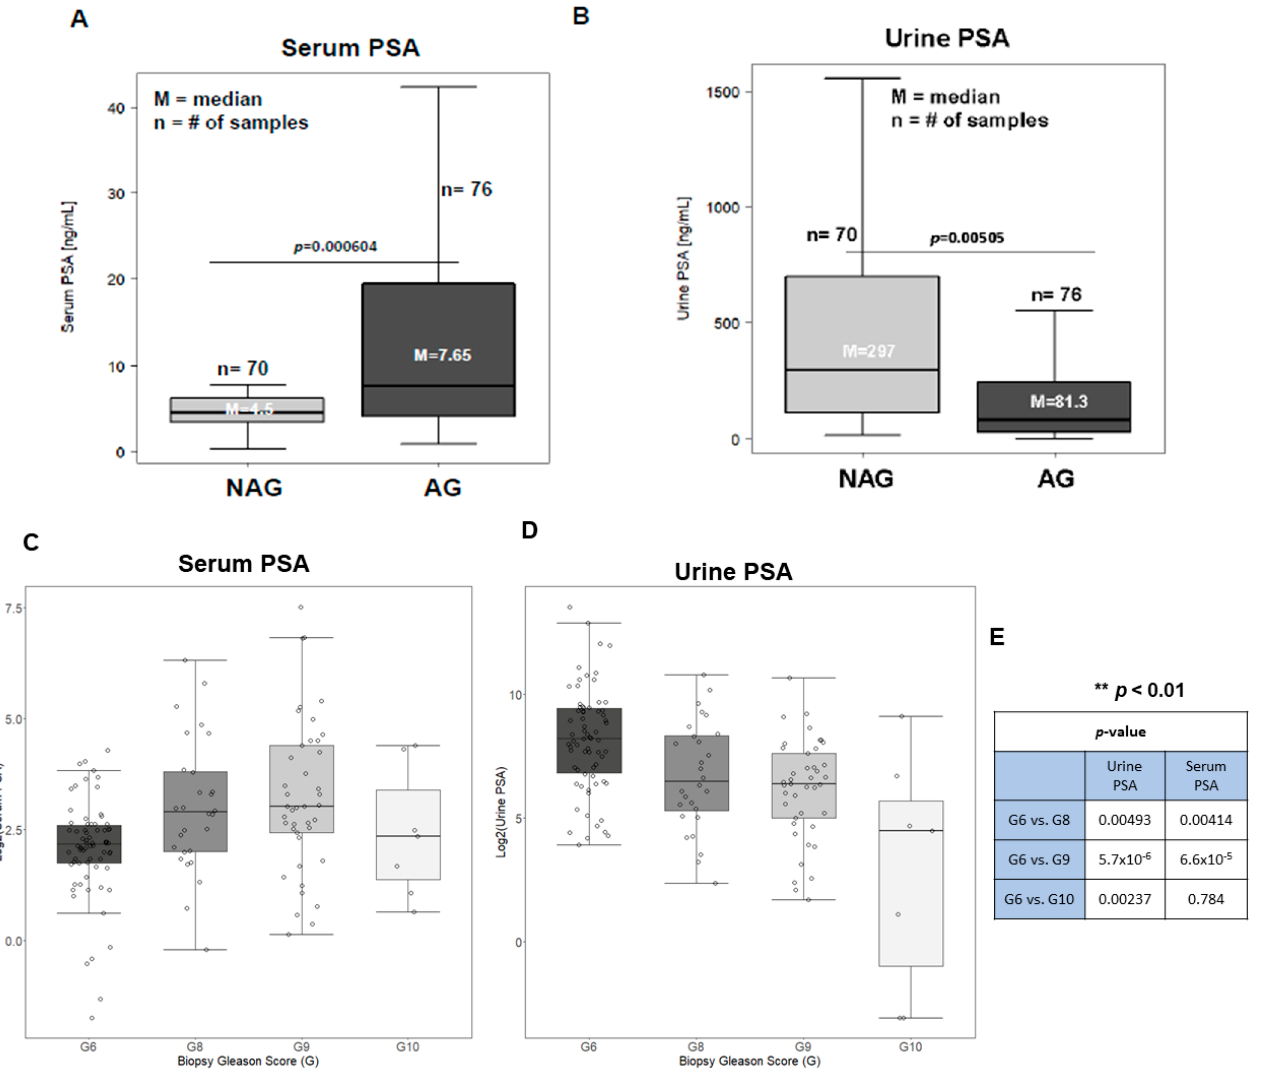
Figure 1. Levels of serum and urine PSA in non-aggressive (GS ≤ 6) and aggressive prostate cancer (GS ≥ 8): Beckman Coulter Access 2 Immunoassay for PSA was performed on n = 146 serum ( A ) and urine ( B ) samples obtained from the same patients. Median levels of serum PSA levels for the NAG patients (n = 70) were found to be 4.6 ng/mL, and for AG patients with (n = 76), they were 7.65 ng/mL ( A ). Urine PSA levels were measured using the same Beckman Coulter Access 2 immunoassay in 146 prostate cancer patients. Median urinary PSA level for NAG patients was 297 ng/mL, compared to the 81.3 ng/mL in AG prostate cancer patients. Significance was defined at p ≤ 0.05. Serum and urine PSA from the same patients were analyzed based on different Gleason scores, and the serum PSA ( C ) and urinary PSA ( D ) levels were plotted using box and whisker plots. The p values between serum and urinary PSA at different GS are shown in table E. Statistical significance was defined as when the p value was p ≤ 0.05 ( E ).